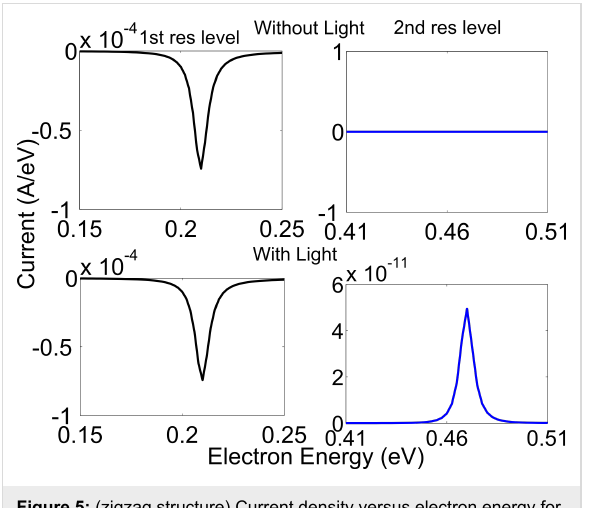
Figure 5: (zigzag structure) Current density versus electron energy for light detection by coupling light between two resonant peaks (top) without light (bottom) with light.